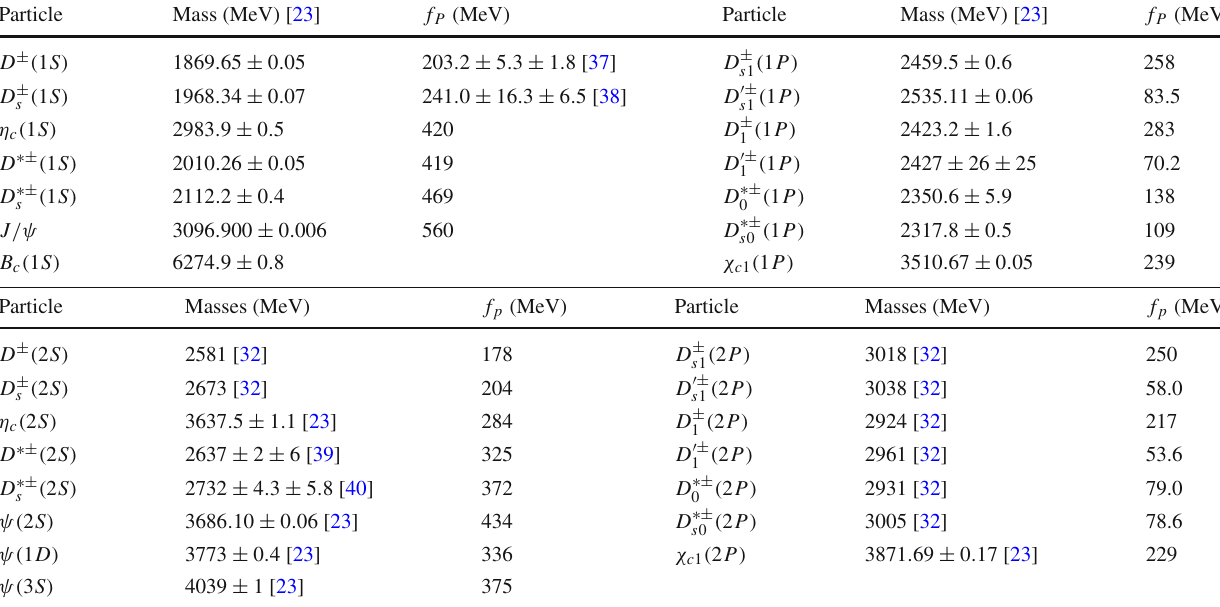
Table 1 The masses and decay constants of mesons